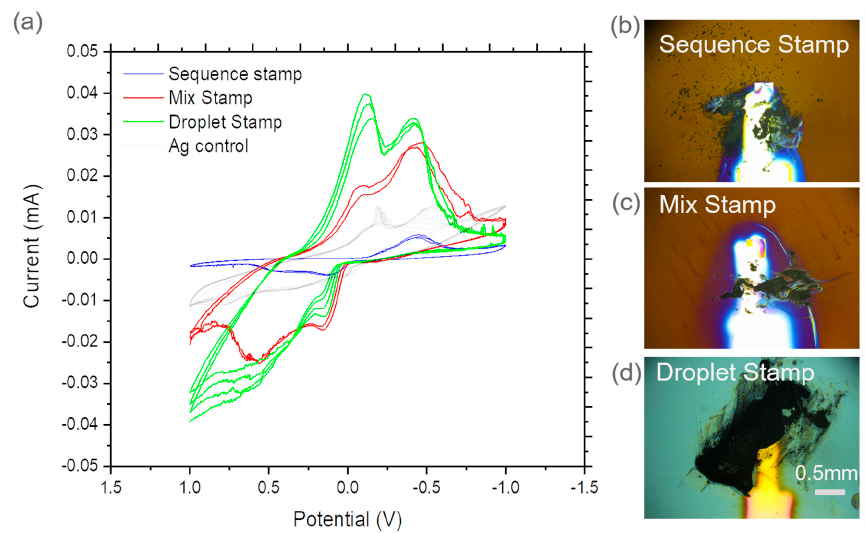
Figure 4. ( a ) CV comparisons of WE surfaces containing CeO 2 nanoparticles using three stamping methods and the control device and optical microscope image of ( b ) sequence stamping, ( c ) mixing and stamping; and ( d ) droplet spraying and stamping. The shining finger-like feature in ( b – d ) is the Au conductive layer.